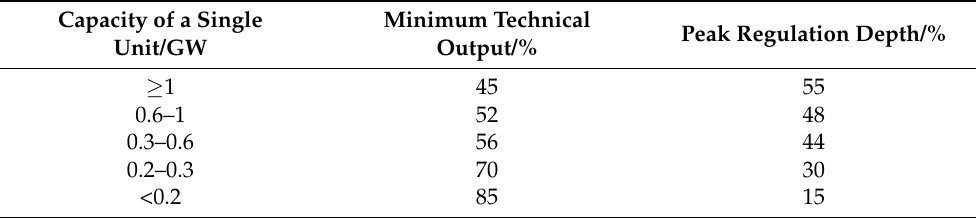
Table 2. Calculation setting of peak regulation depth for coal-fired power units typed by